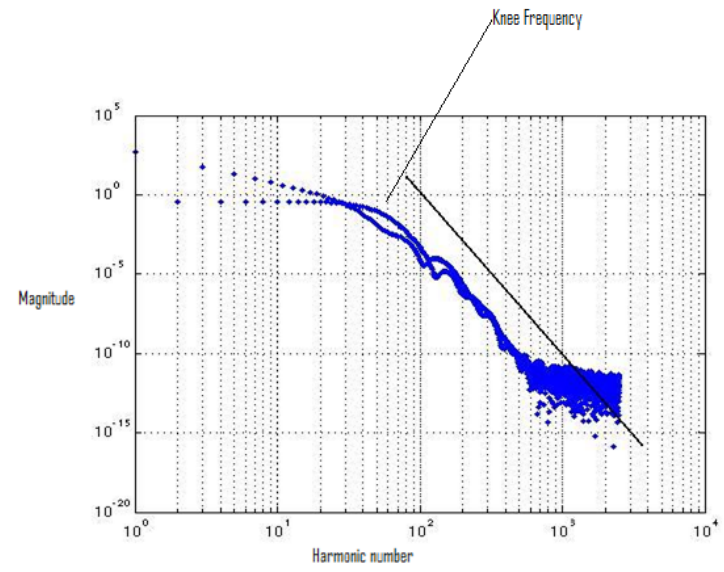
Figure 3. Spectrum plot of the inverter switching waveform.